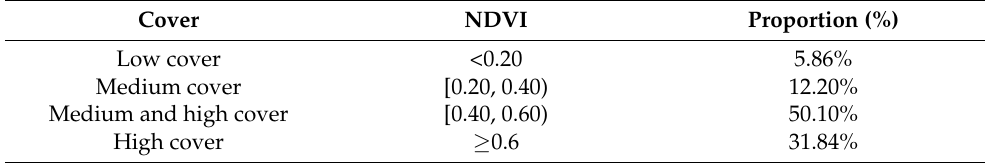
Figure 5. Spatial distribution of vegetation cover in the Yangtze River Basin from 2000 to 2019. Table 3. Classification standard and data statistics of vegetation cover in the Yangtze River Basin.